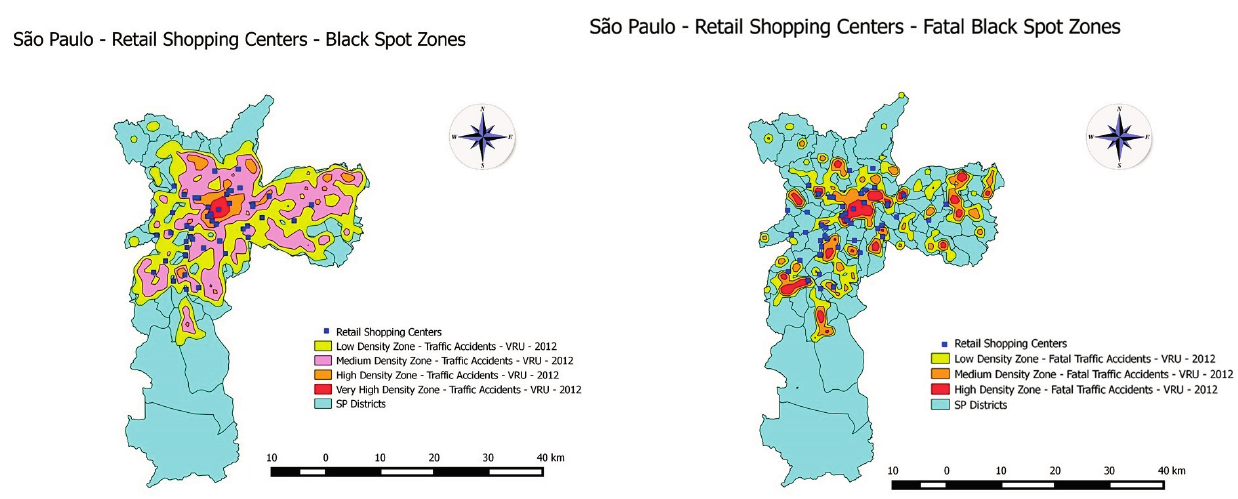
Figure 11. Retail shopping centers/black spots: São Paulo.